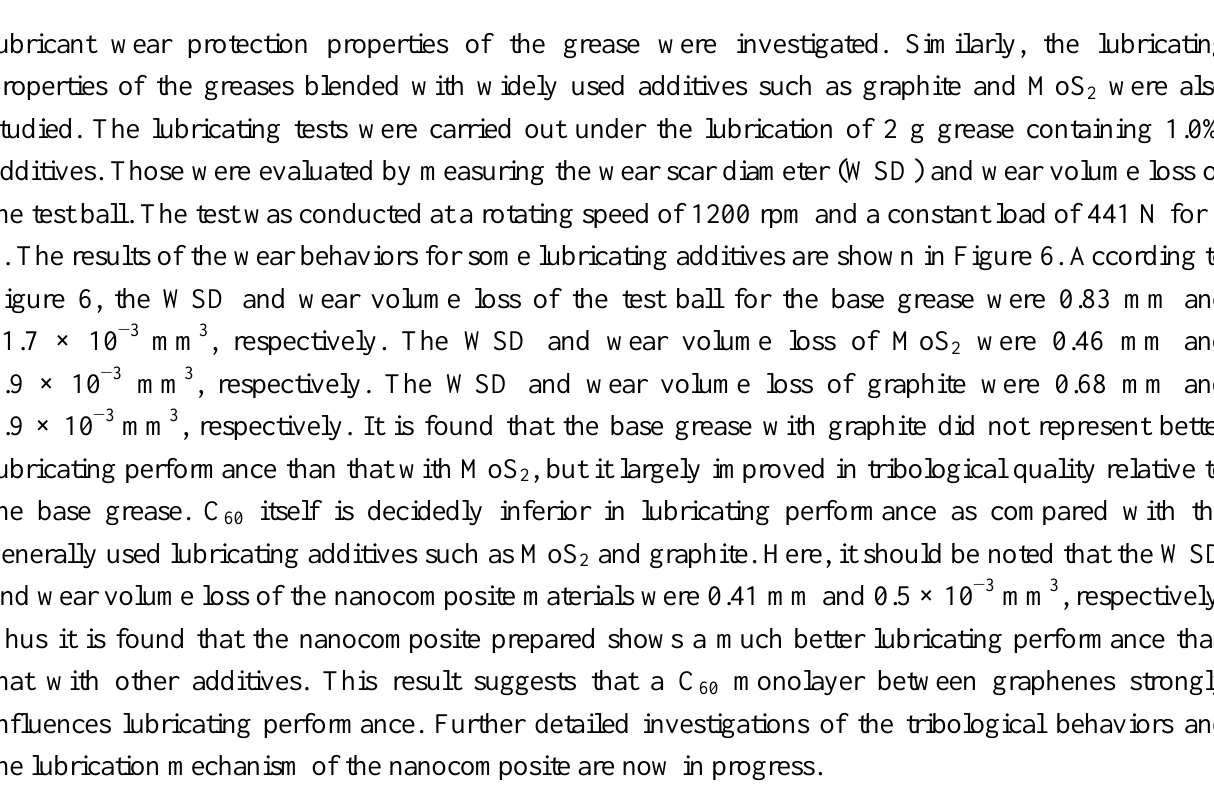
Figure 6. The wear scar diameter (WSD) and wear volume loss of the test ball for the grease with various kinds of